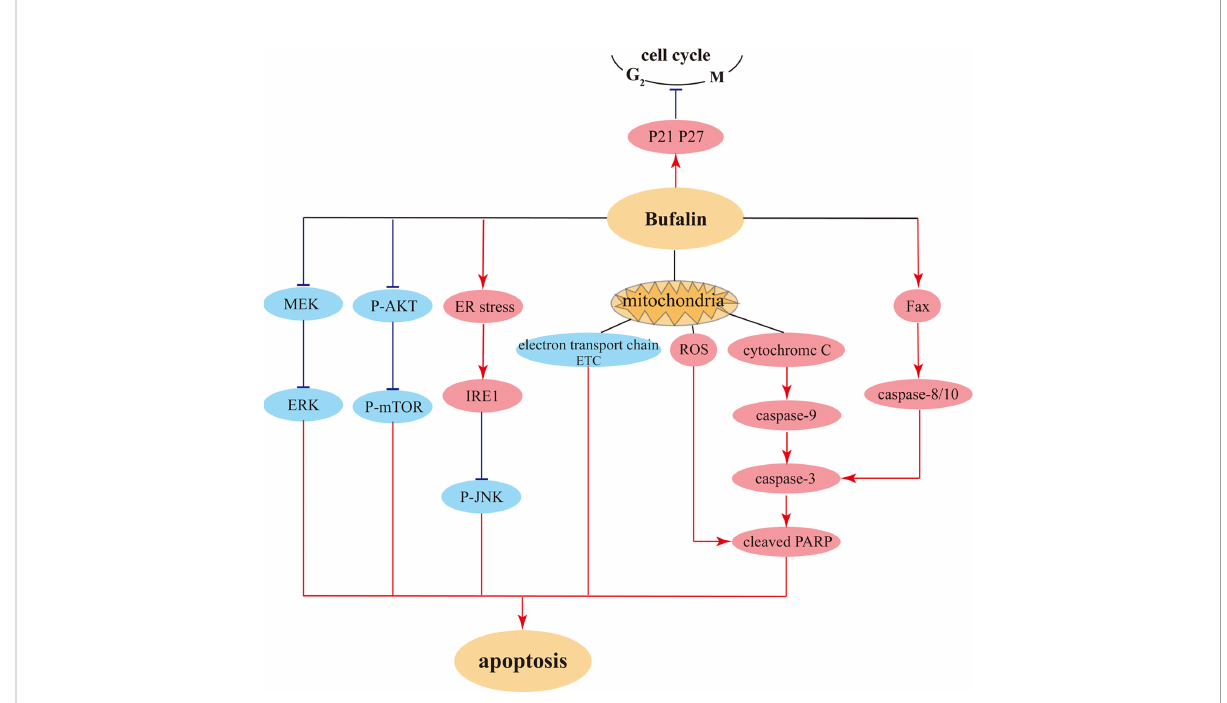
FIGURE 4 The possible pathways for bufalin induced cell cycle arrest and pro-apoptosis in tumor